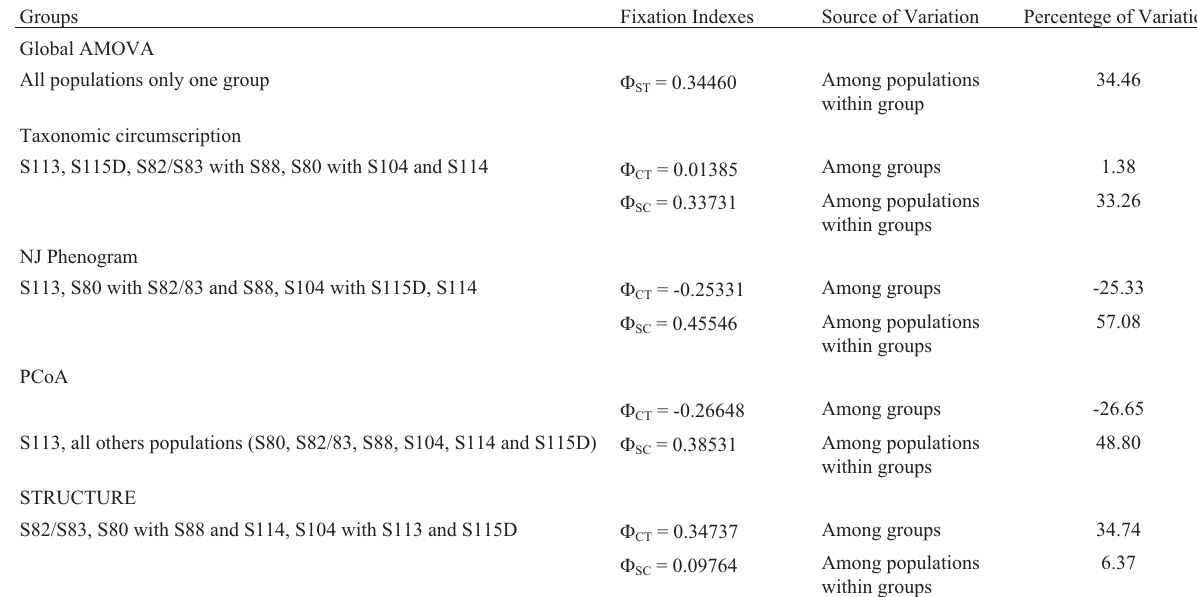
Table 3 - Global and hierarchical Analysis of Molecular Variance (AMOVA). For hierarchical AMOVA the a priori groups are based on taxonomic cir- cumscription, NJ phenogram, PCoA and STRUCTURE. Groups Fixation Indexes Source of Variation Percentege of